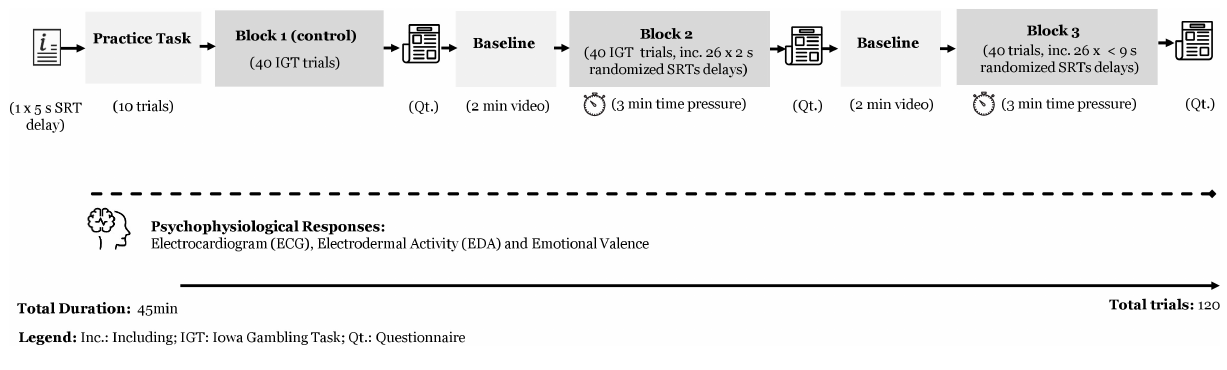
FIGURE 3 | Experimental